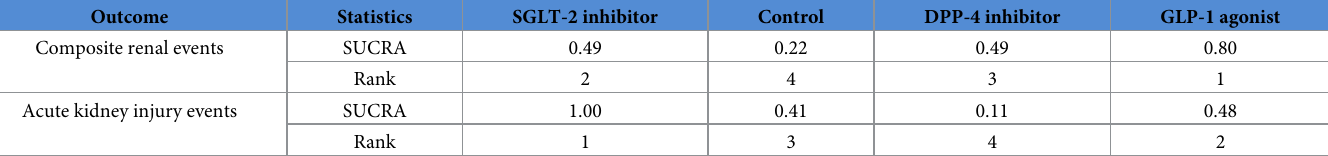
We found that the mean BMI, mean age, mean baseline HbA1c, and mean duration of diabetes were all reasonably similar across treatment comparisons when we used box plots to measure transitivity (Appendix 6 in S1 Text) . The global inconsistency test found no significant differ- ence between the consistency and inconsistency models for two outcomes (p = 0.902 for com- posite renal events and p = 0.626 for acute kidney injury events in Appendix 7 in S1 Text ). After constructing the node-splitting models, we found that no significant inconsistency existed in all networks except for acute kidney injury events (Control vs SGLT-2i and DPP-4i vs SGLT-2i; Appendix 7 in S1 Text ). Heterogeneity (global I 2 )was low for both our primary and secondary outcomes (10% and 15%, respectively). At visual inspection, comparison- adjusted funnel plots for composite renal outcomes appeared to be symmetric, indicating that there was no significant risk of publication bias in our included studies. However, the funnel plots suggest that there might be small-study effects for AKI events ( S3 Fig and Appendix 3 in S1 Text ). Table 1. Ranking based on simulations for